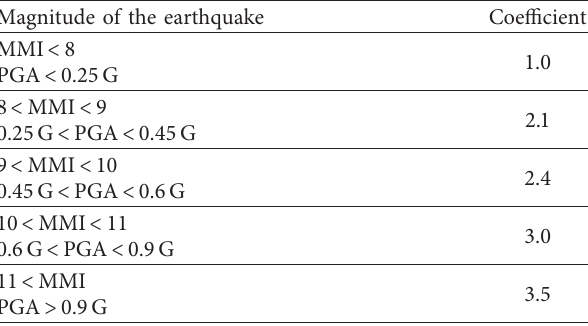
Table 6: Weighted coefficient for magnitude of the earthquake.